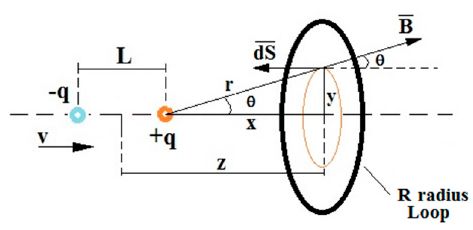
Figure 5. Transducer scheme using the magnetic dipole.